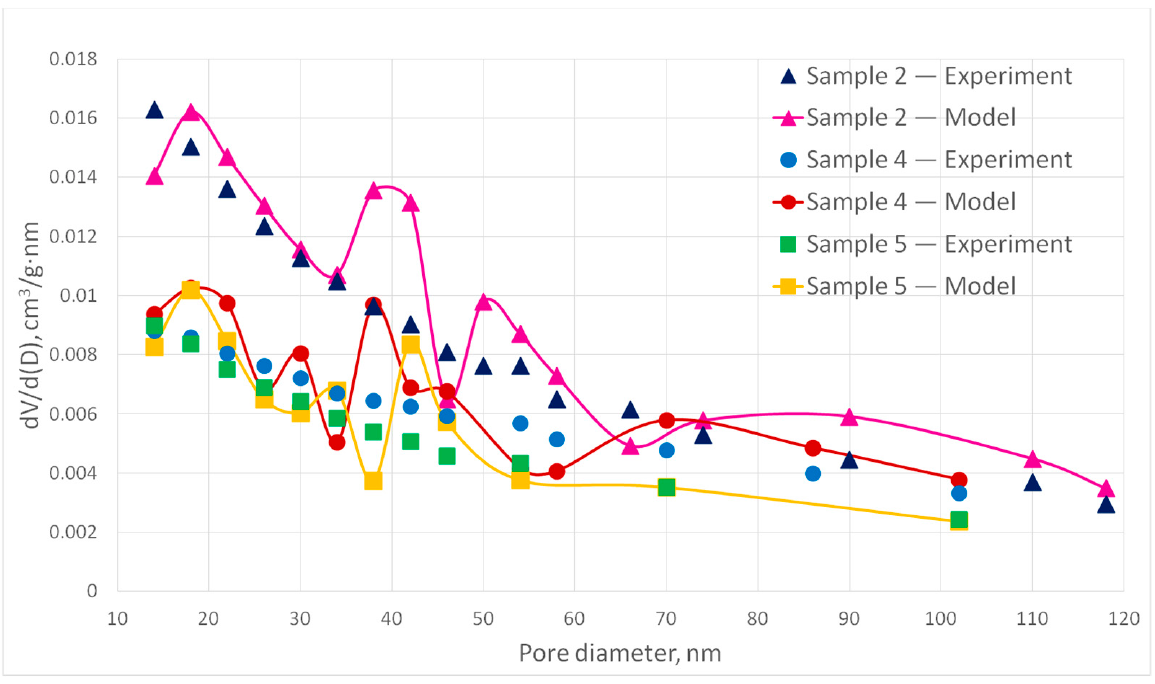
Figure 20. Experimental and corresponding digital structures PSD curves for samples 2, 4 and 5. The deviation of the calculated values of the pore size distribution curves from the